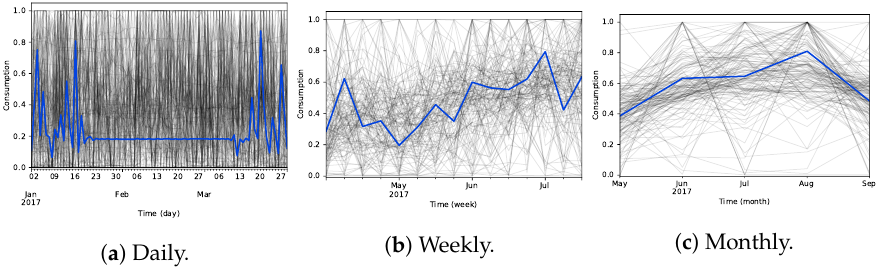
Figure 20. Coclusters and barycenters for the daily, weekly, and monthly dataset at InfraQuinta,